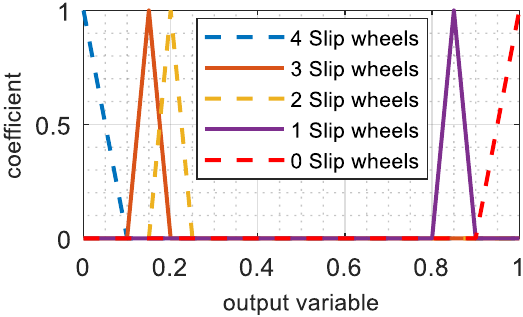
Figure 5. Final fuzzy logic algorithm output variables.